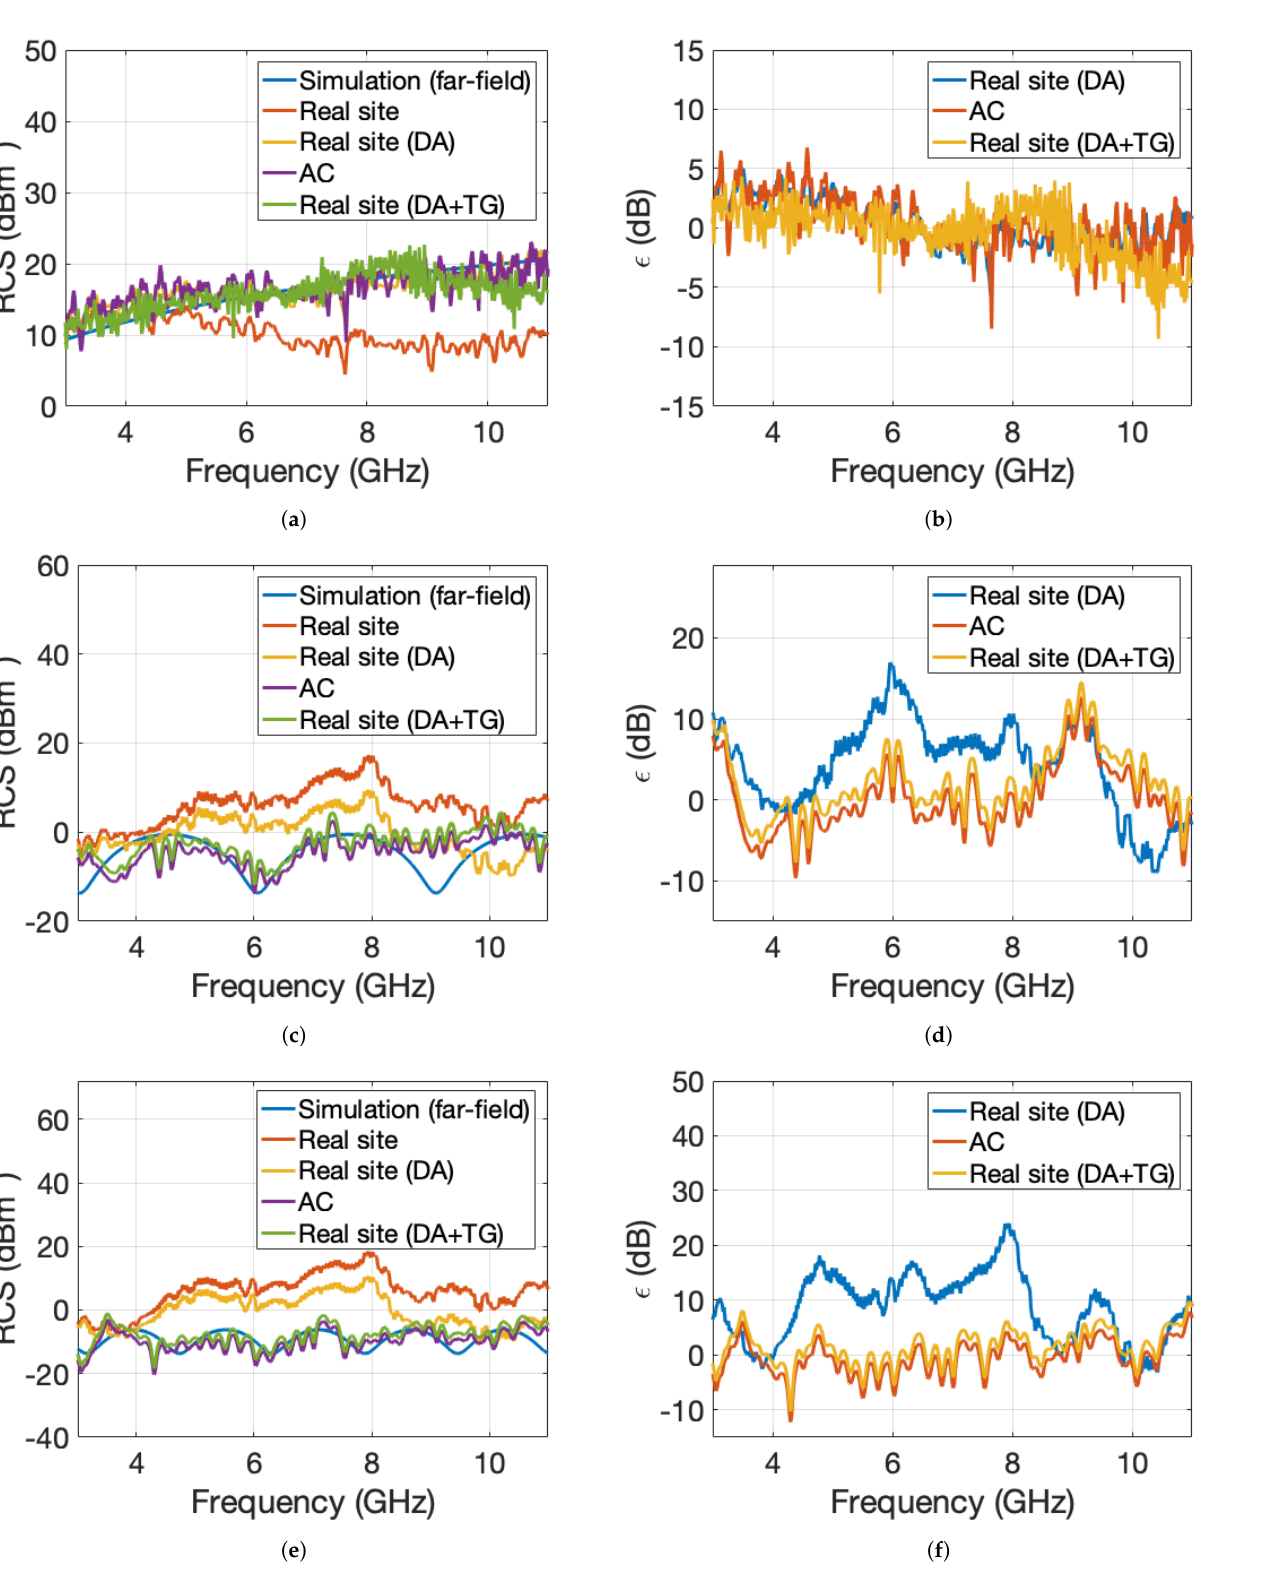
Figure 7. Comparison between simulated far-field RCS, RCS measured at near-field distances, RCS measured at near-field distances corrected with F (in an AC or in a real site, after applying DA or a combination of DA and TG), at θ = 0° ( a ), θ = 15° ( c ) θ = 25° ( e ). Absolute error between the RCS measured at near-field distances corrected with F (in an AC or in a real site, after applying DA or a combination DA+TG), and the far-field RCS simulations at θ = 0° ( b ), θ = 15° ( d ) θ = 25° ( f